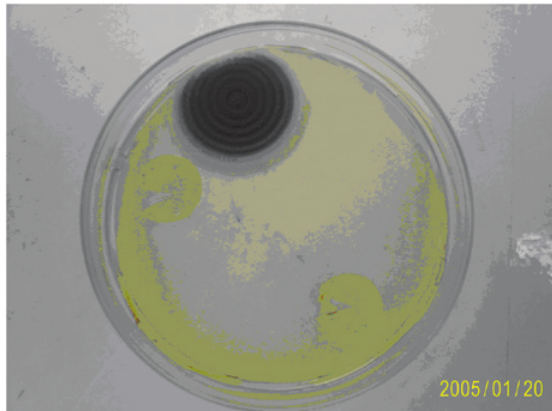
Figure 4: Fungal growth adjacent to a Hydron (expiry date 2009) blister packed contact lens after twenty six days of incubation. (Please ignore the date due to incorrect camera set-